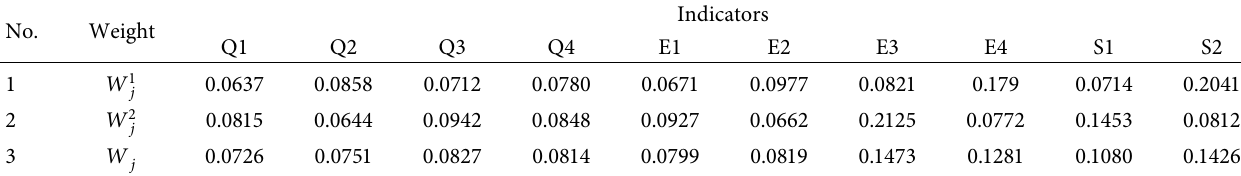
Table 4: Weight coefficients of each evaluation indicator.